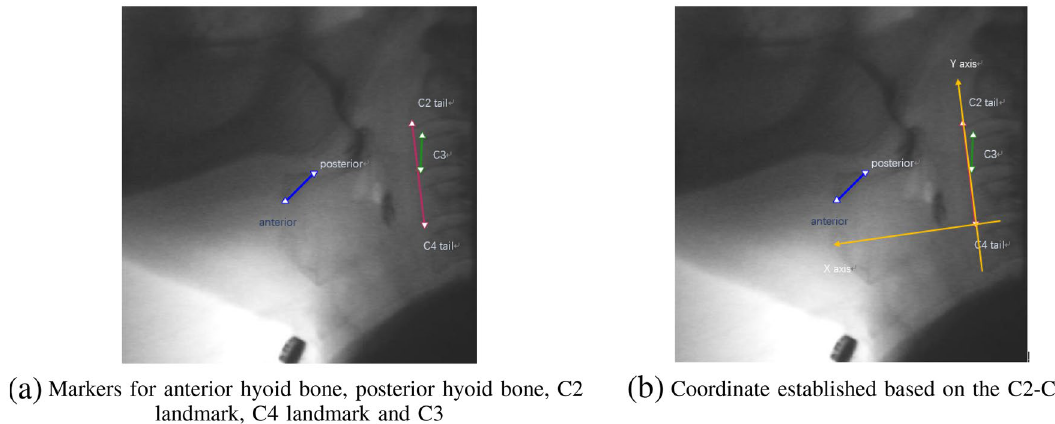
Fig. 1 The figures illustrate the markers for hyoid bone, C2, C3, C4 and how to establish the coordinate for hyoid bone